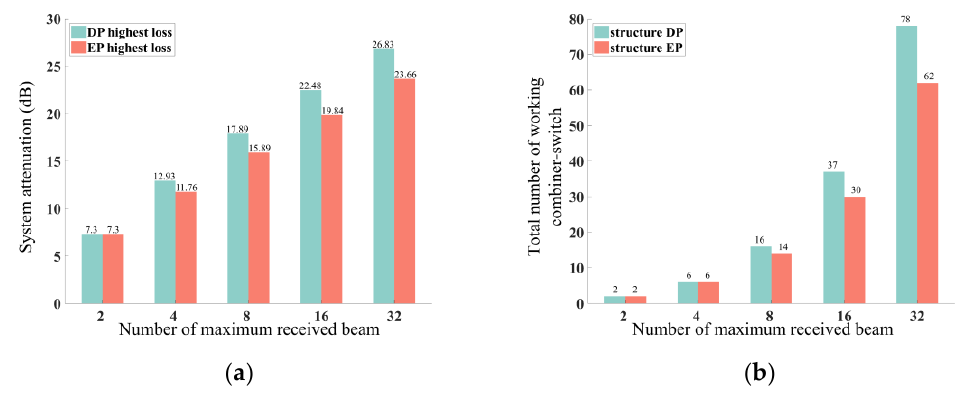
Figure 4. The comparison of the parameters when beam number N = 2, 4, 8, 16, 32. ( a ) The comparison of system attenuation with X = 2 dB, L = 3.3 dB; ( b ) The comparison of total number of working combiner-switch.